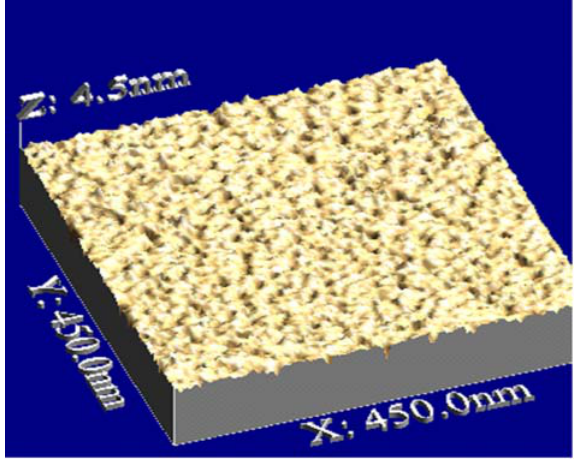
Fig. 8 AFM images of silica (ETMS) hybrids containing 5 mol % calcium